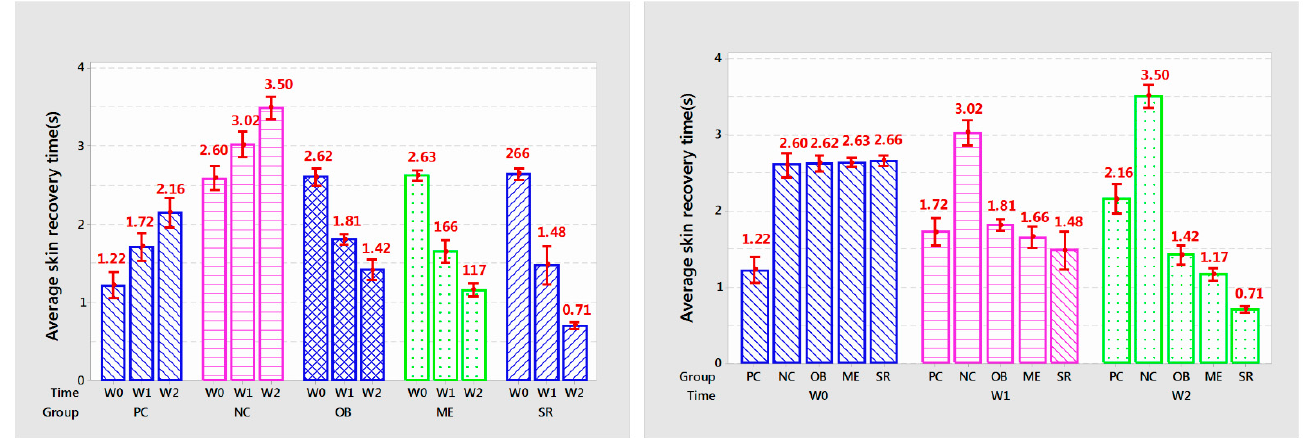
the Figure 4. The graph shows the average number of skin recovery times after each week of applying the product.